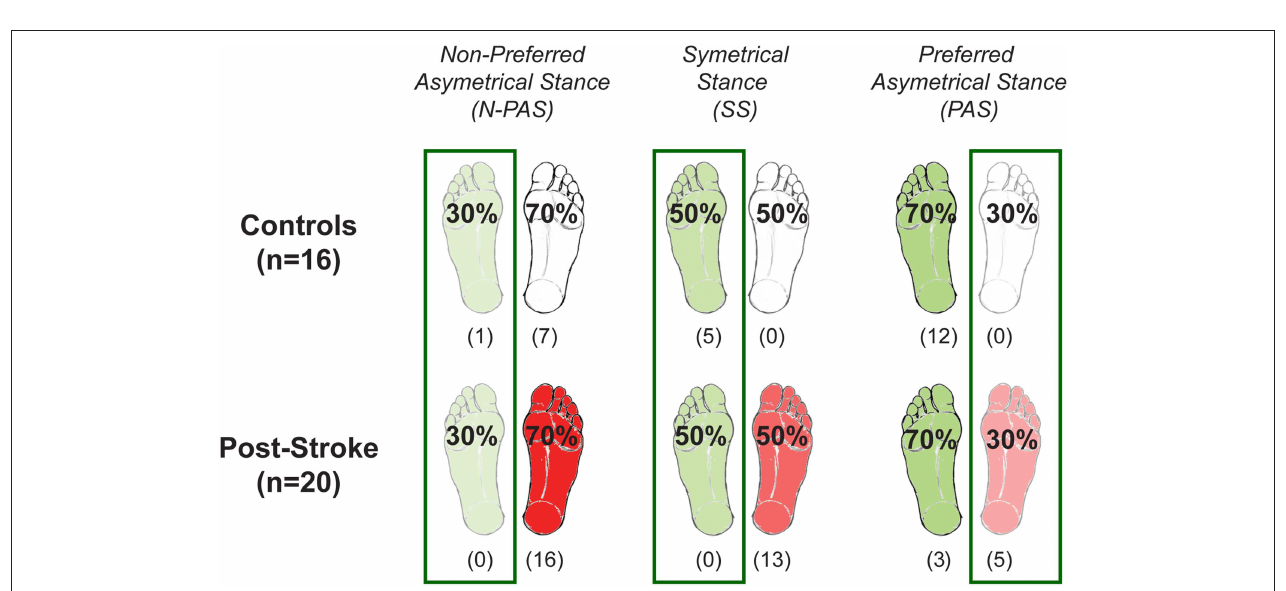
FIGURE 1 | Experimental setup and protocol. A mechanical weight-drop waist-pull perturbation was applied in the anterior direction. When the participants maintained a pre-instructed weight-bearing load on the force plate for 250–1,000ms, it released an electromagnet and triggered the free-fall of a weight equal to 10% of the subject body weight. The perturbation device was behind a screen, and a monitor provided visual feedback to the subjects on their standing weight-bearing symmetry.